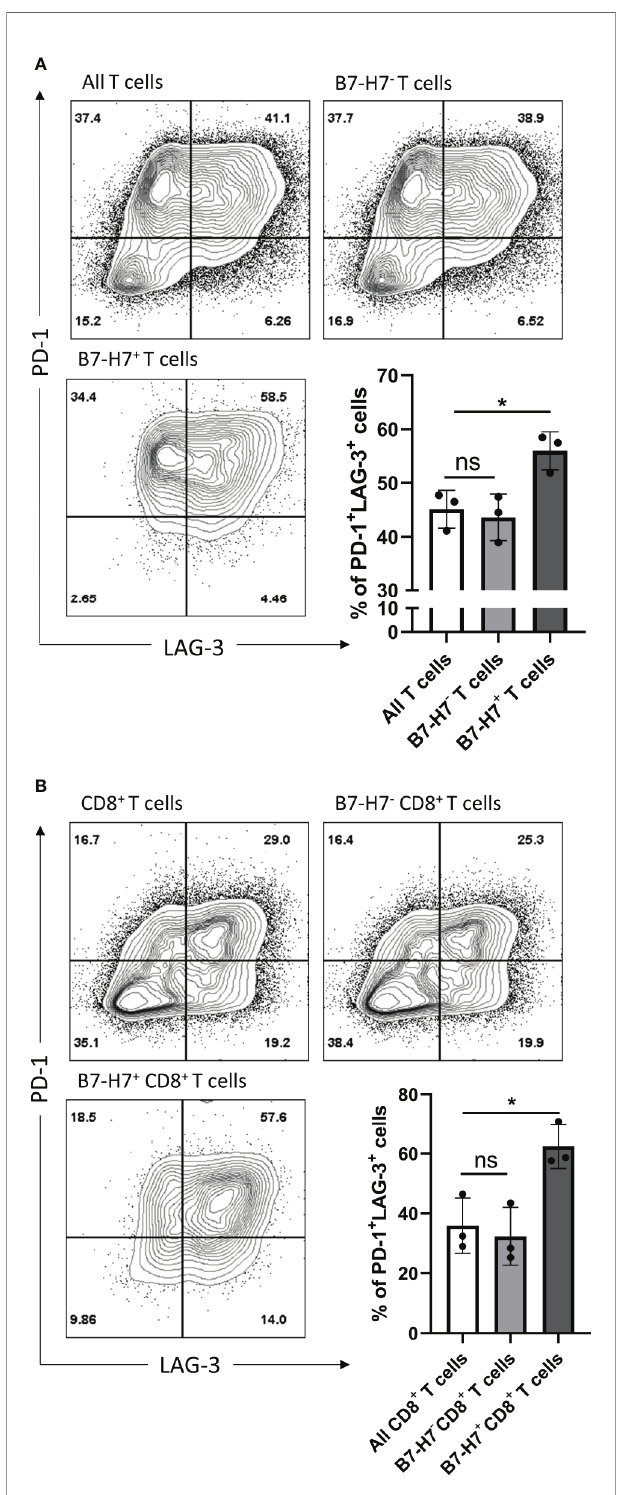
FIGURE 6 | B7-H7 + T cells show an exhausted phenotype. Puri fi ed T cells (A) or puri fi ed CD8 + T cells (B) were activated with recommended dose of TransAct ™ (1:100) for three days and assessed for B7-H7, PD-1 and LAG-3, n=3. Cells were gated for live and single cells. ns, not signi fi cant, *p < 0.05, one-way ANOVA was used, followed by multiple comparison